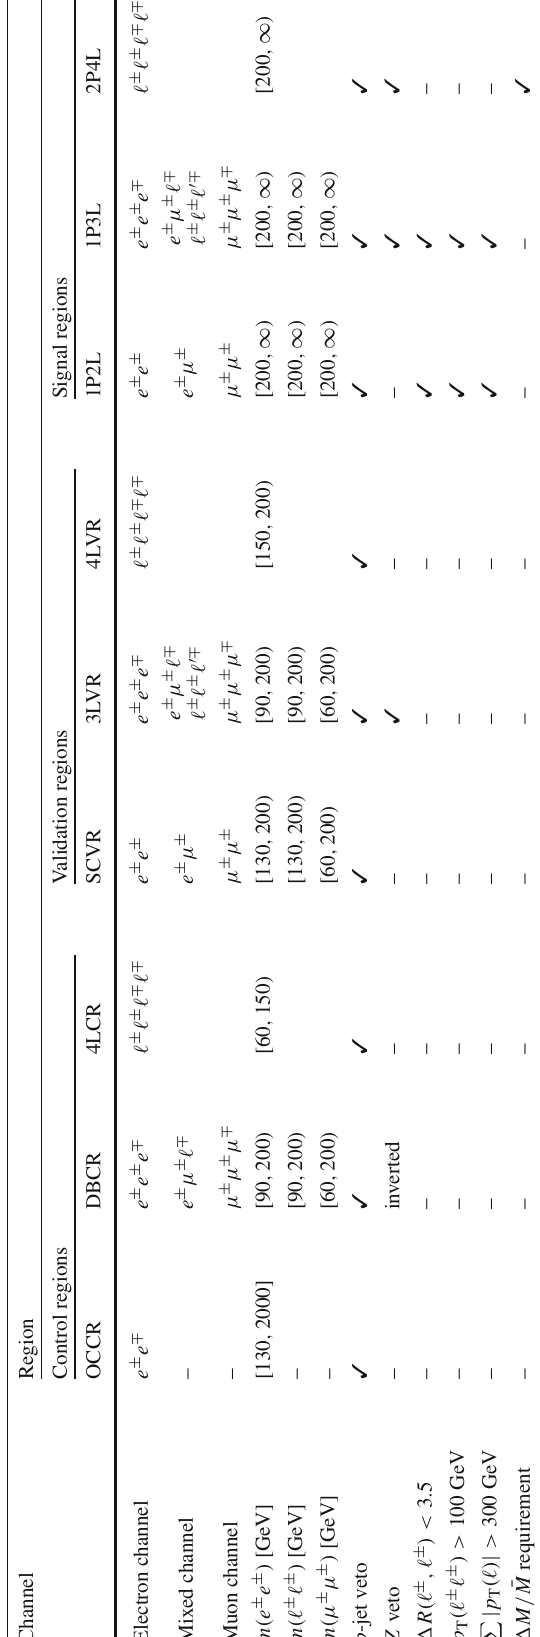
same-charge Z → ee peak (see Fig. 2) were minimised by construction following the methodology described in Sect. 5,